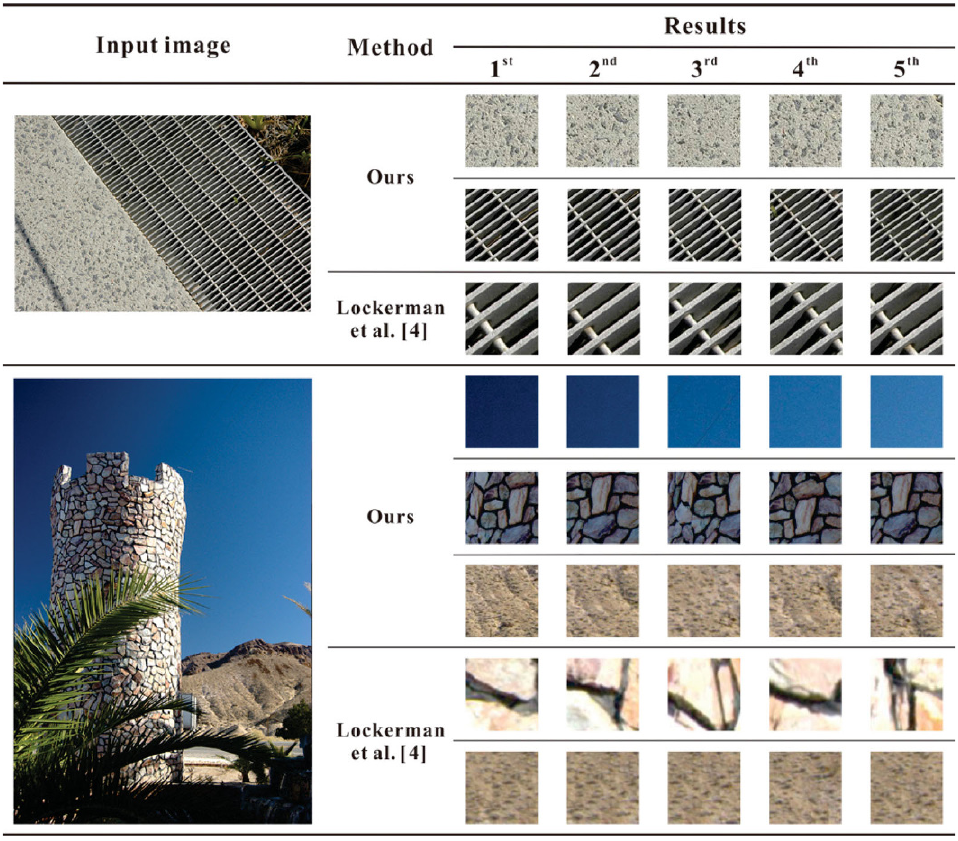
Fig. 8 Patches chosen by our method and that of Lockerman et al. [4]. Input images and the results of Lockerman et al.’s method were obtained from http://graphics.cs.yale.edu/site/tr1483